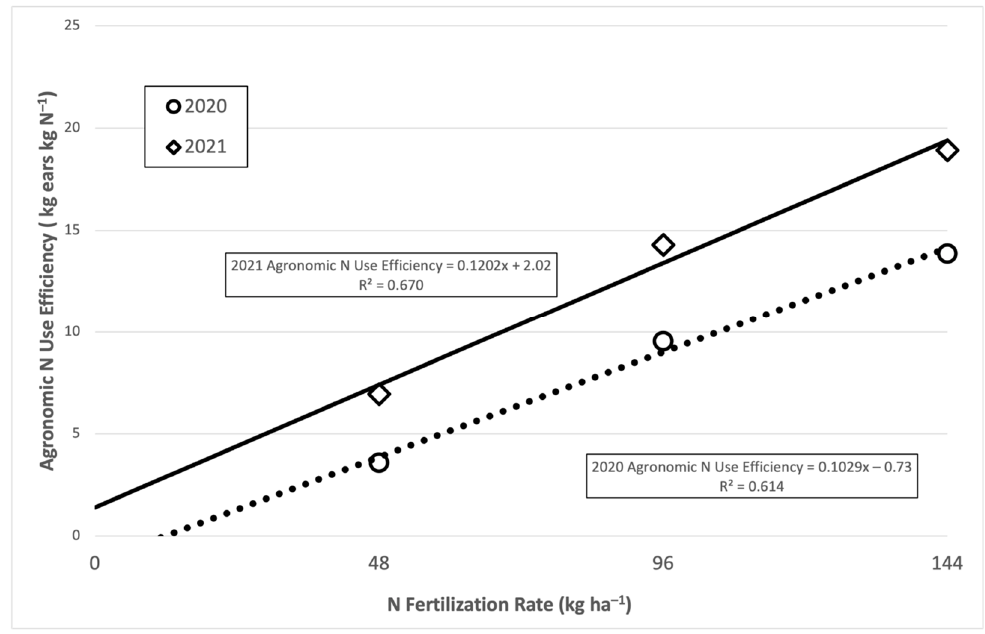
Figure 11. Mean agronomic N use efficiency in sweet corn as a function of N fertilization rate in 2020 and 2021. Goodness of fit described with conditional R 2 .